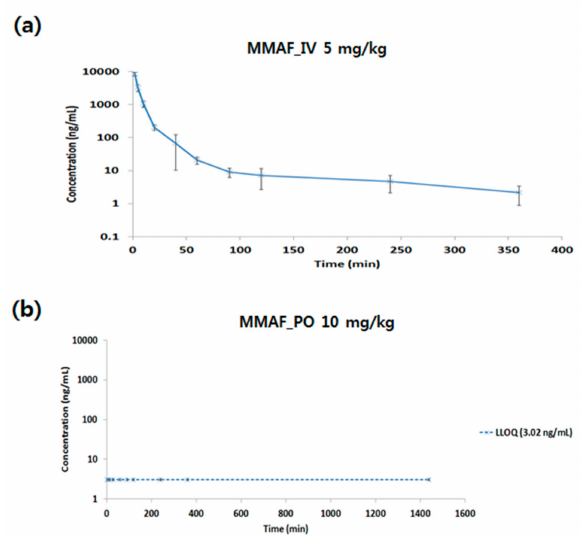
Figure 3. Pharmacokinetic profile of MMAF (monomethyl auristatin F) after ( a ) intravenous (IV) (5 mg / kg) or ( b ) oral (PO) (10 mg / kg) administration in